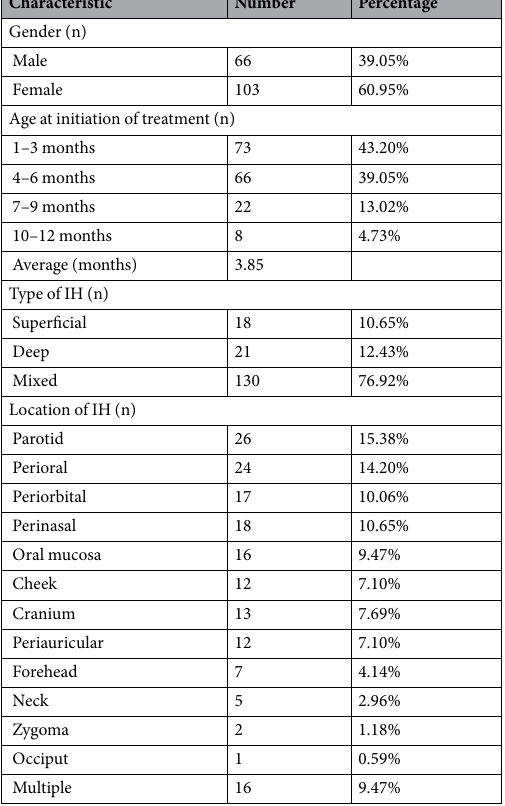
Table 1. The clinical data of infants with head and neck infantile haemangioma.